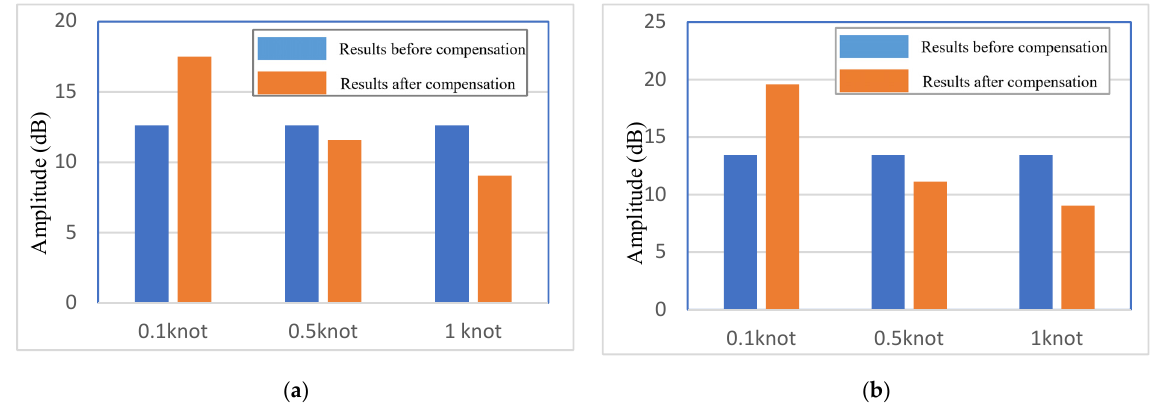
Figure 21. Statistical table of the SNR for the two targets before and after motion compensation under different velocity errors: ( a ) target 1, ( b ) target 2.